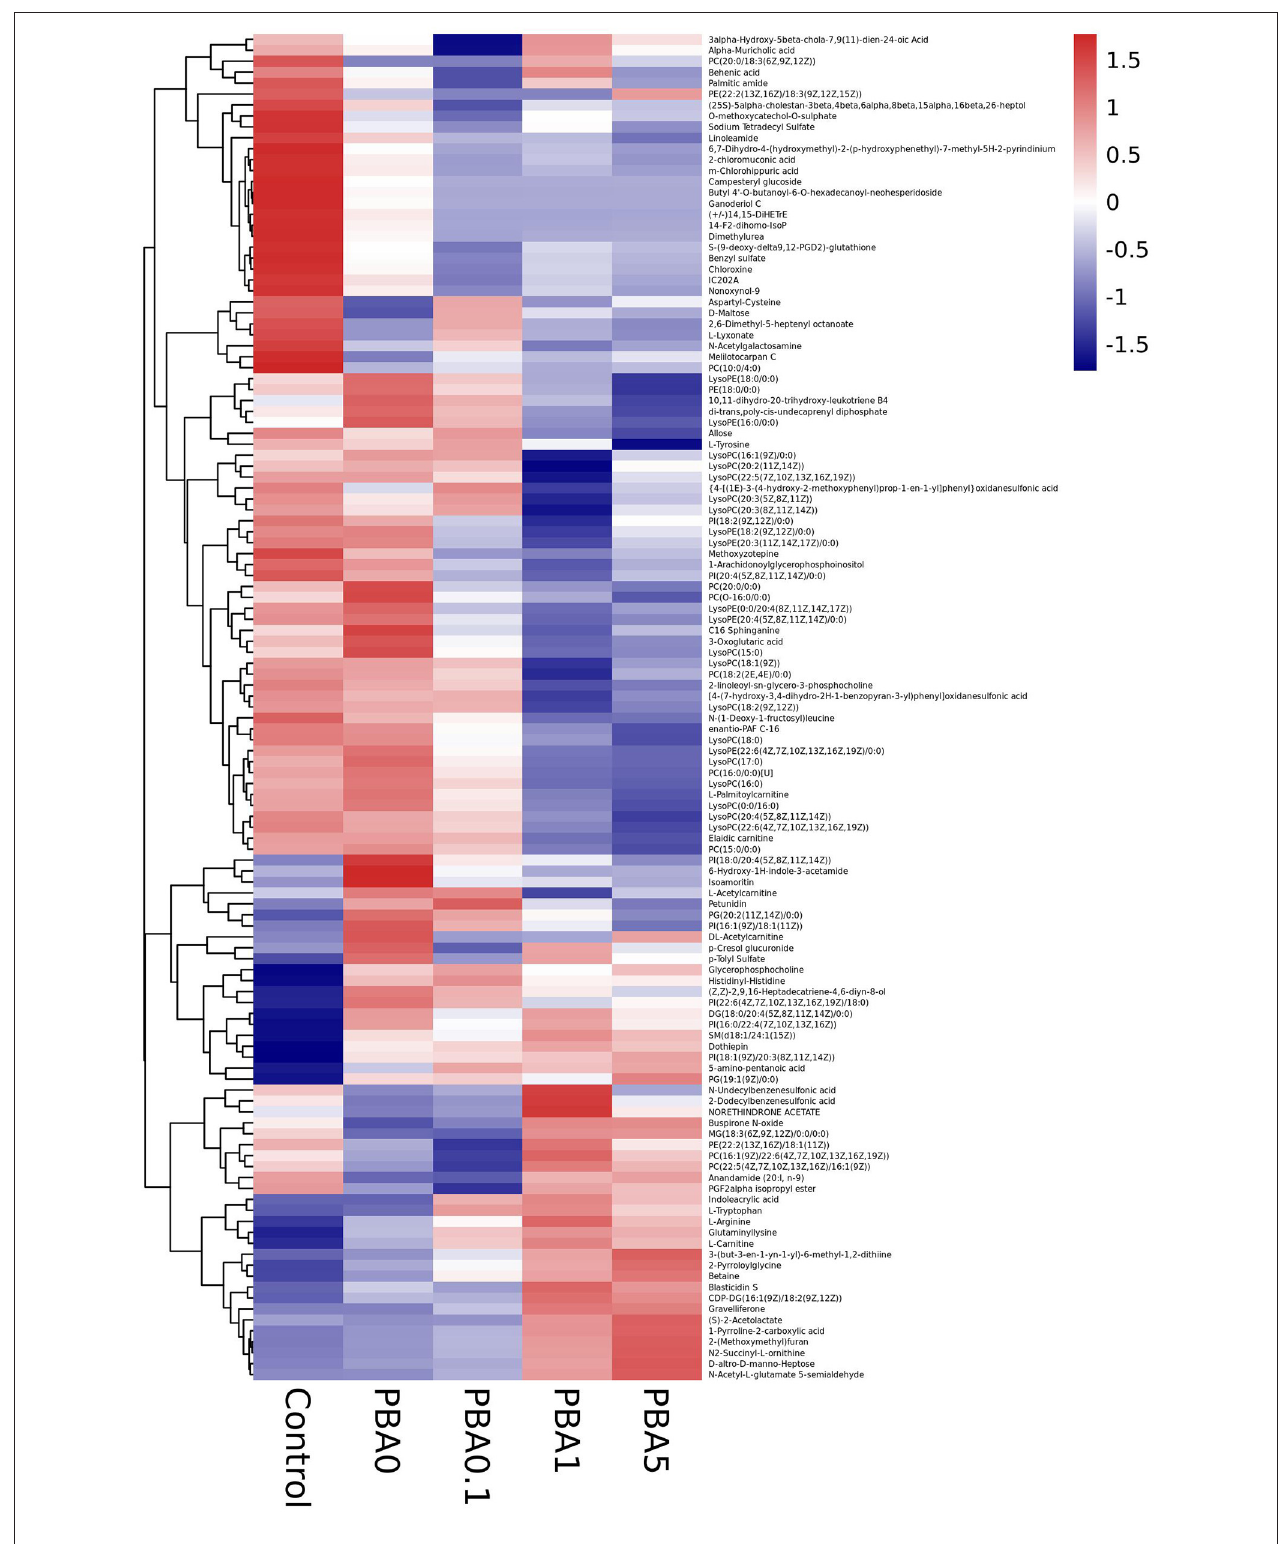
FIGURE 7 | Heat map analysis of metabolites in different treatment groups.